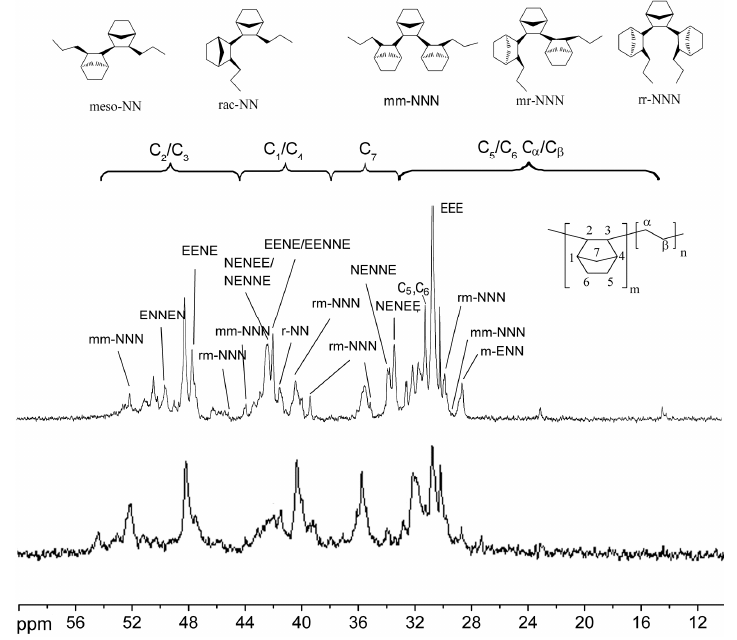
Figure 4. 13 C NMR spectra of E–N copolymers obtained at different ethylene pressures (up: 20 atm (entry 4), down: 0.5 atm (entry 7)).